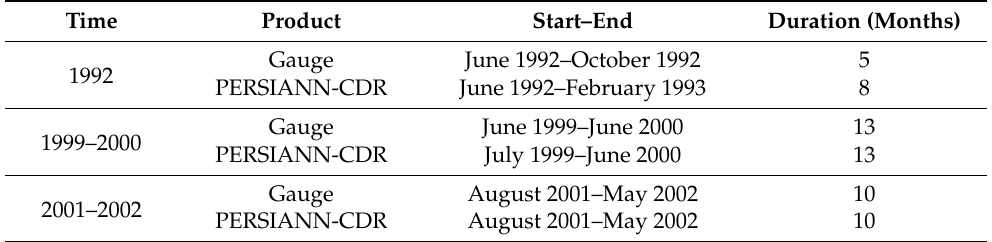
Table 3. Characteristics of three typical drought events at the 12-month